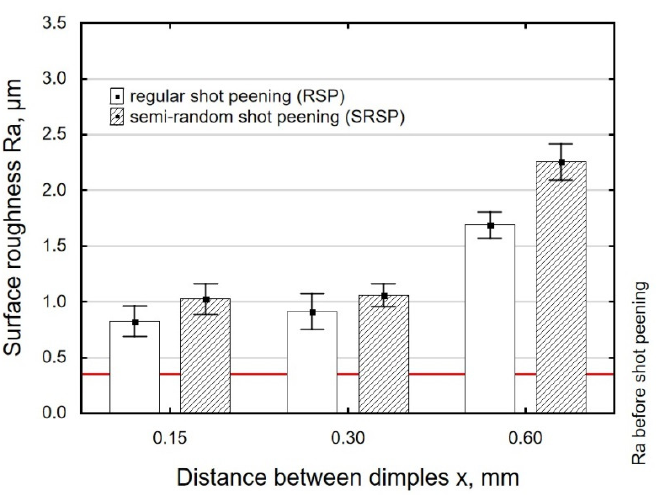
Figure 9. Distance between dimples versus roughness parameter Ra (impact energy E = 100 mJ, ball diameter D = 10 mm).